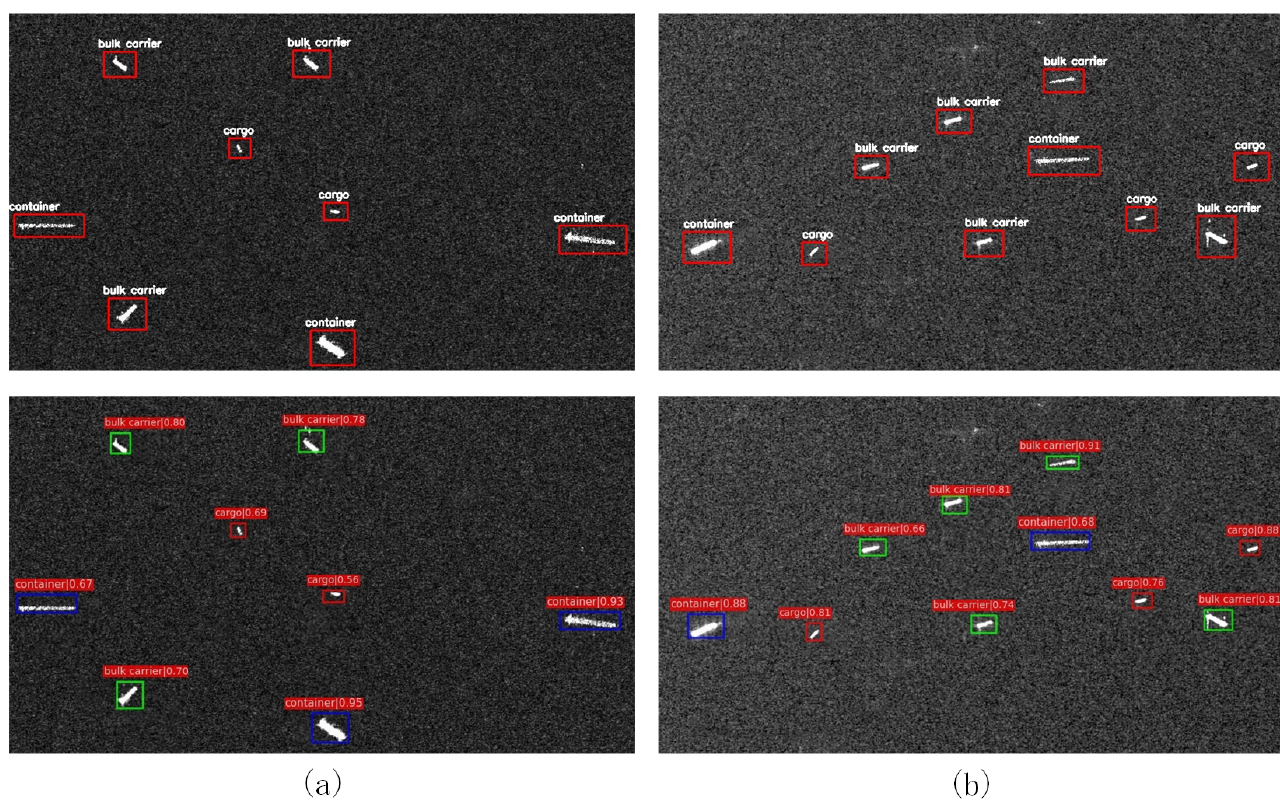
Figure 8. Ocean experiments in large SAR scene. The images at the top are with the target truth boxes, and the images at the bottom are the detection results of the proposed